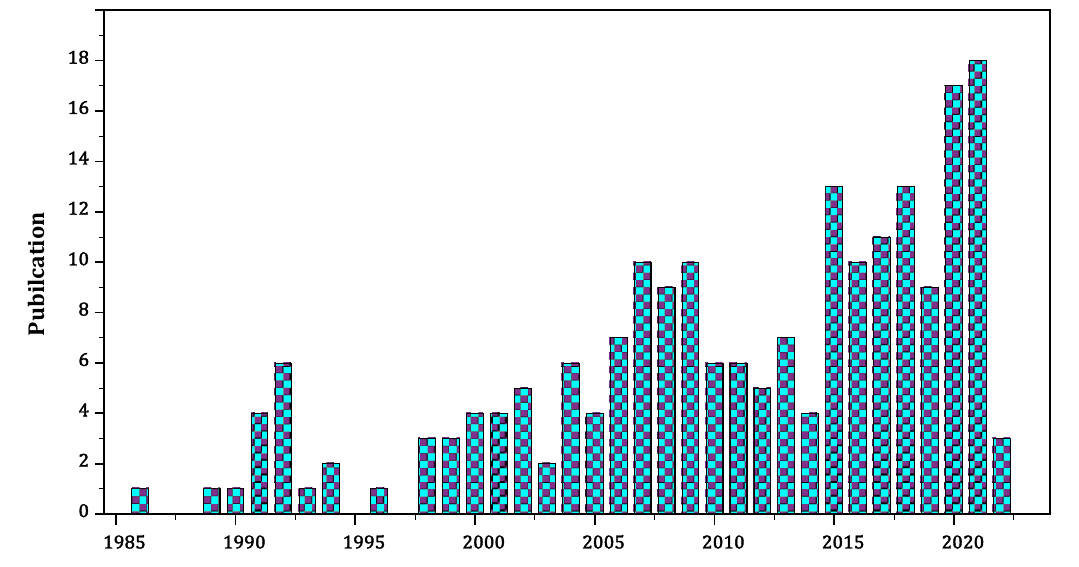
Year Figure 1. Number of research publications based on licorice Figure 1. Number of research publications based on licorice polysaccharides.